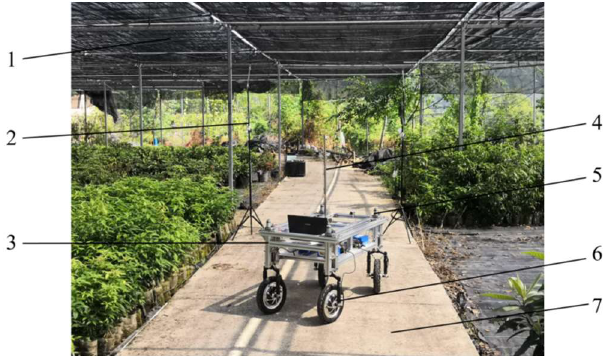
Figure 1. Test prototype and test environment. (1) Greenhouse; (2) UWB anchor; (3) test prototype; (4) UWB signal receiver; (5) steering gear; (6) drive motor; (7) test path.